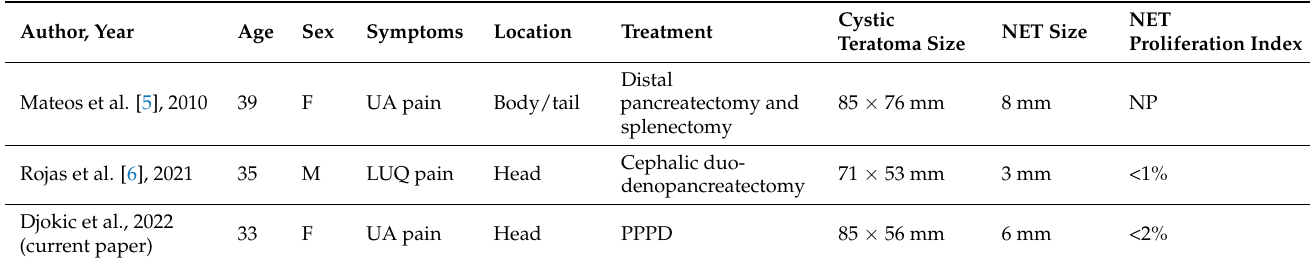
Table 1. Characteristics of patients with concomitant mature cystic teratoma of the pancreas and neuroendocrine